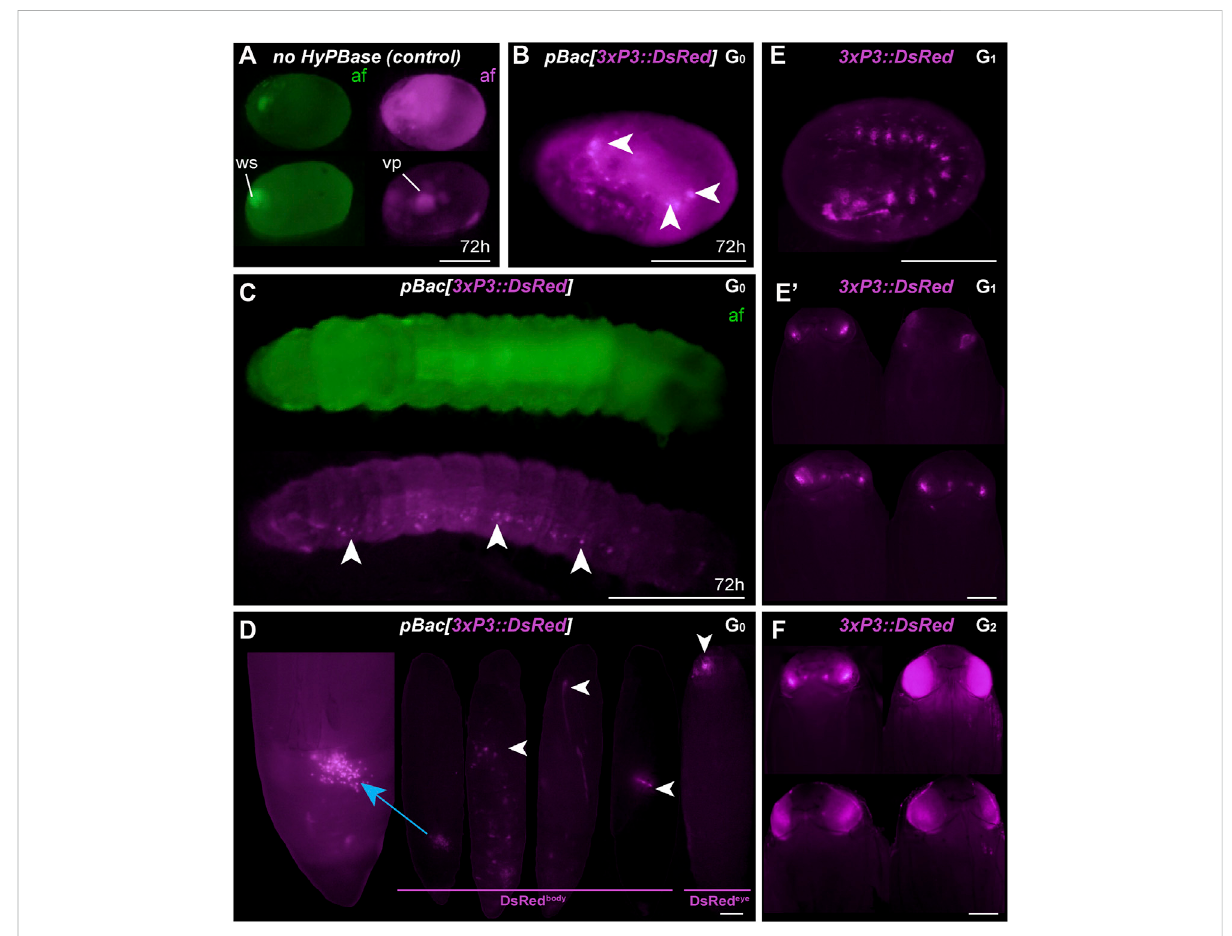
FIGURE 3 Somatic and germline transgenesis of 3xP3:DsRed . (A) Two control eggs (top and bottom rows) injected with only pBac[3xP3::DsRed] show backgroundauto fl uorescence levelsinthe DsRed channel (af, magenta) at72 h post-injection, includingresidual signal invitellophages (vp). Wound site(ws)auto fl uorescenceislimitedtotheEGFPchannel(af,green). (B – C) HyPBase mRNAand pBac[3xP3::DsRed] resultinglialexpressionof 3xP3:: DsRed (magenta)ininjectedembryos.OcellarexpressionwasnotobservedintheseexperimentsattheG 0 phase. (D) G 0